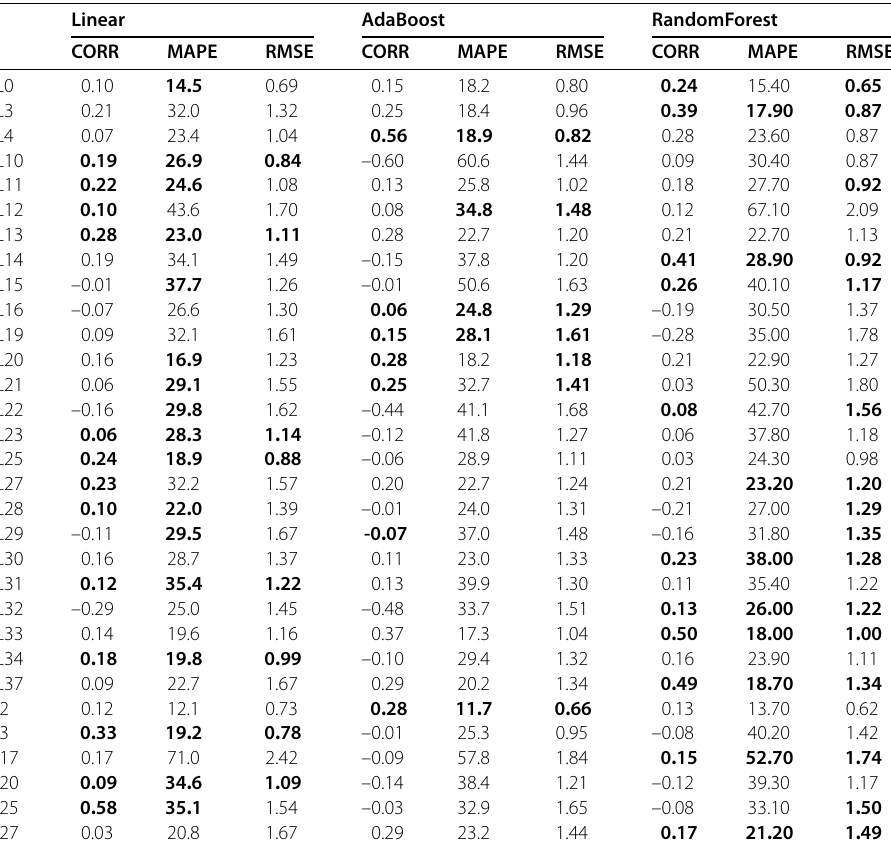
Table 7 ILI prediction results (current week estimates for %ILI) for 2014 for 31 locations from affect features using Linear, AdaBoost and Random Forest regressors